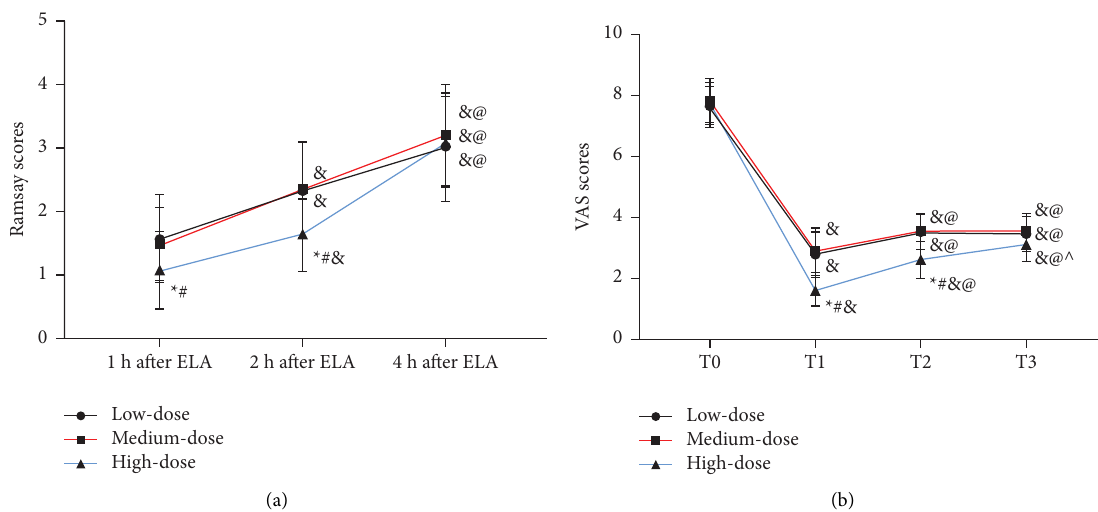
Figure 1: Comparison of analgesic efects. (a) Comparison of the Ramsay score. Note . Compared with the low-dose group, ∗ P < 0 . 05; compared with the middle-dose group, # P < 0 . 05; vs. 1 h after ELA, & P < 0 . 05; vs. 2 h after ELA, @ P < 0 . 05. (b) Comparison of VAS scores. Note . Compared with the low-dose group ∗ P < 0 . 05; compared with the middle-dose group, # P < 0 . 05. Note . Compared with the low-dose group, ∗ P < 0 . 05; compared with the middle-dose group, # P < 0 . 05; vs. T1, & P < 0 . 05; vs. T2, @ P < 0 . 05; vs. T2, ^ P < 0 .